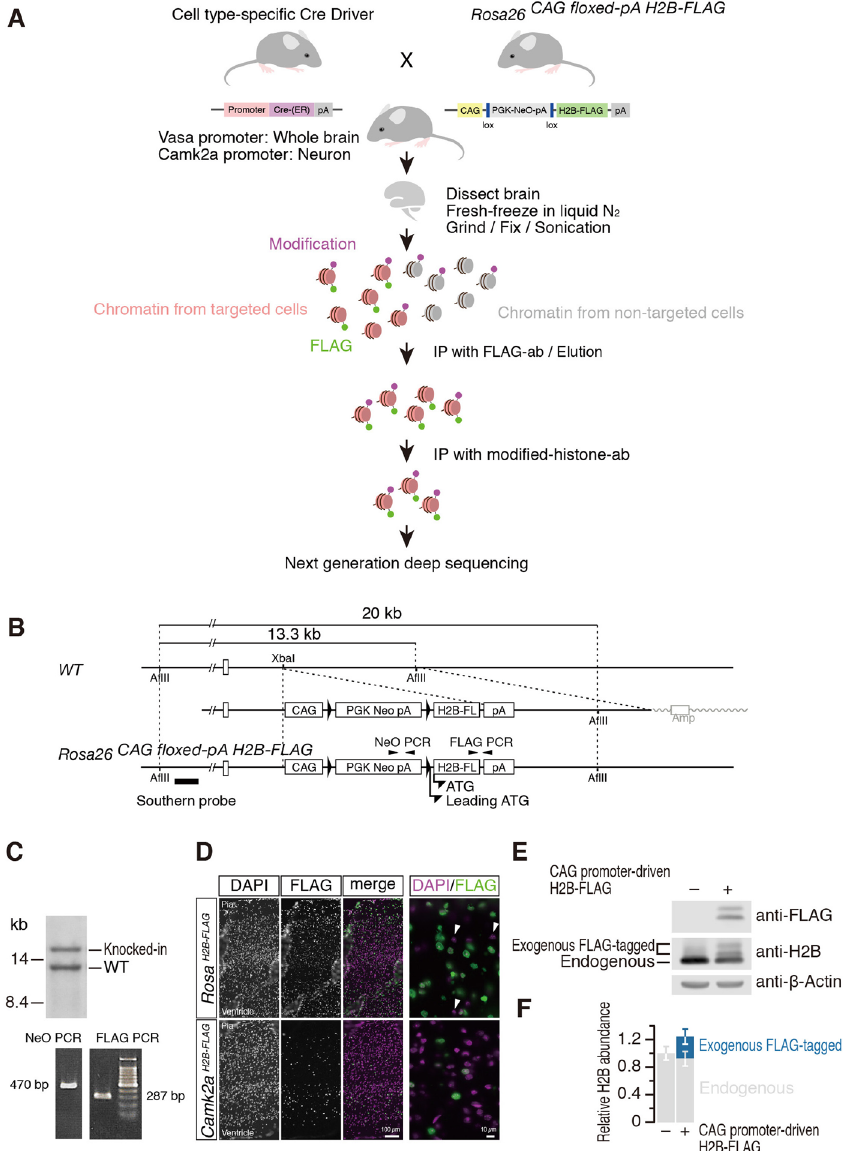
Figure 1. Genetic labeling of cell type-specific chromatins by H2B-FLAG. ( A ) Schematic drawings of the experimental design. Cell type-specific expression of H2B-FLAG was induced by crossing Cre-driver mice that express Cre recombinase in a particular cell type with floxed H2B-FLAG mice that possess an expression cassette of H2B-FLAG upon Cre-mediated recombination. Chromatins from cell types of interest were recovered from cellular lysate prepared from whole tissues by immunoprecipitation using an anti-FLAG antibody. Then, subsequent ChIP with antibodies against a specific chromatin modification, H3K4me3 in this study, was performed. ( B ) Schematic drawings of the targeting strategy to generate Rosa26 stop-floxed CAG-H2B-FLAG mice. CAG, CAG promoter: PGK, PGK1 promoter: Neo, neomycin resistant gene: H2B-FL, H2B-FLAG: pA, polyadenylation signal of bovine growth hormone. Designed and leading in-frame ATG codons for H2B- FLAG are depicted. Position of the probe used for Southern blot analyses is shown in a bold bar. Positions of primers used for genotyping are indicated by arrowheads. ( C ) Southern blot analyses of the targeted ES cells used for generation of the chimera mice, and the agarose gel electrophoresis images of genotyping PCR. ( D ) Expression of H2B-FLAG in the cortical plates of Rosa H2B-FLAG and Camk2a H2B-FLAG mice. H2B-FLAG was almost ubiquitously expressed in the cortical cells in Rosa H2B-FLAG mice. Occasional and exceptional cells that did not express the tagged protein were indicated by arrow heads. In the cortical plate of Camk2a H2B-FLAG mice, H2B-FLAG expression was observed only in large cortical neurons identifiable by large, round nuclei, as expected from a previous report on the Cre-driver mouse 23 . ( E ) Expression levels of the exogenous H2B-FLAG in Rosa H2B-FLAG mice was compared to the endogenous H2B expression level. Total cell lysates prepared from the cortical plate of Rosa H2B-FLAG mice were blotted with anti-FLAG, anti-H2B, and anti- β -actin antibodies. ( F ) Quantitation of the results shown in ( E ). Data represent the mean and S.D. (n = 3). The exogenous H2B-FLAG consisted of ~16% of the total H2B